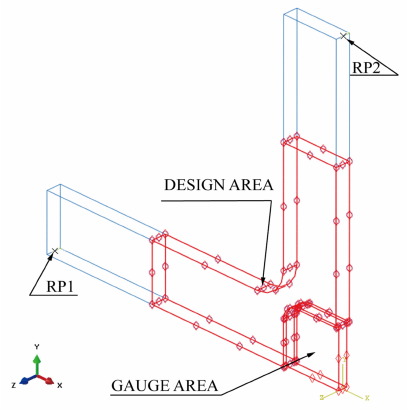
Figure 5. Quarter physical model for topology